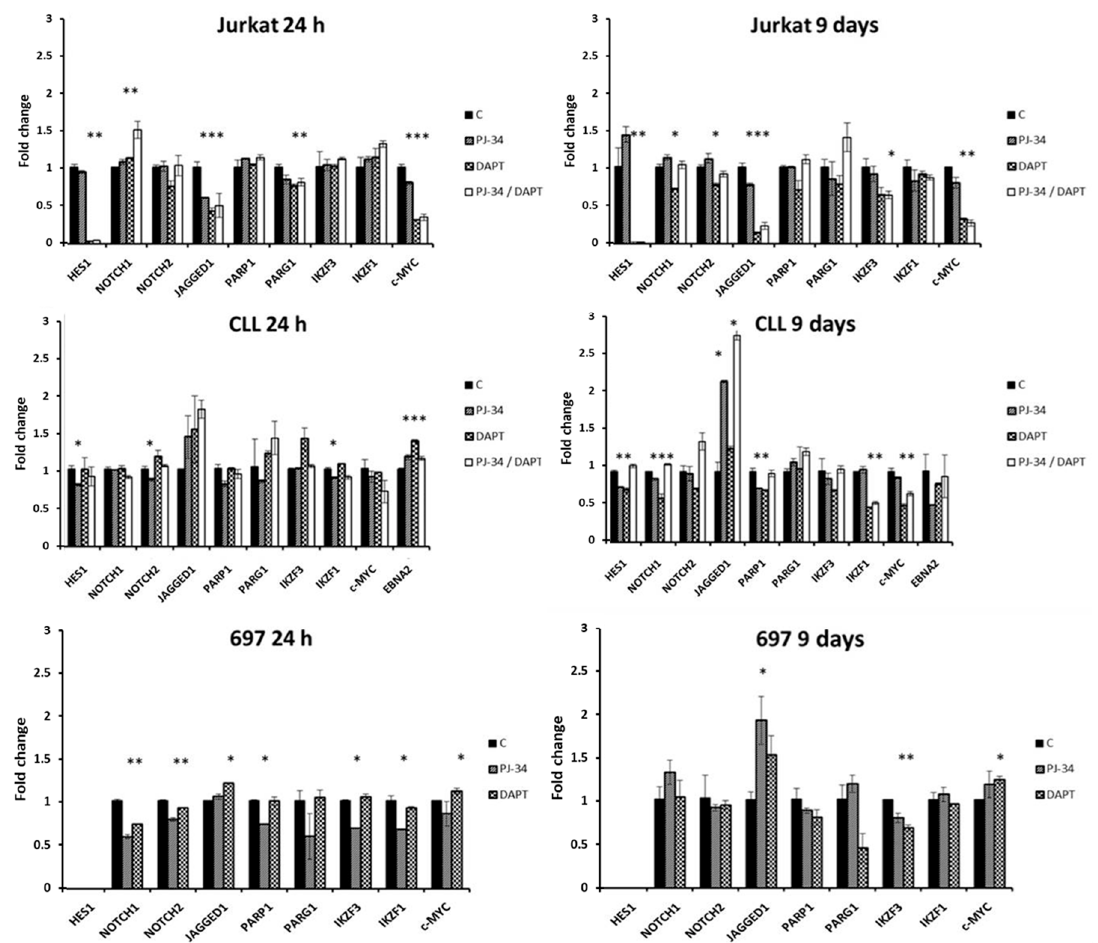
Figure 3. Influence of Notch and PARP pathways’ inhibition in Jurkat, CLL, and 697 cell lines. Cells were treated with PARP inhibitor PJ-34 and/or Notch inhibitor DAPT every other day through nine days, when RNA was isolated and, after reverse transcription, qRT-PCR was performed. Representative results are shown. Relative expression is presented as a fold change in comparison with untreated control sample values. As endogenous control gene HPRT expression was used. C: control cells; PJ-34: cells treated with PJ-34 (10 µM for CLL and Jurkat cells and 40 µM for 697); DAPT: 20 µM DAPT; PJ-34/DAPT: cells treated with combination of 10 µM PJ-34 and 20 µM DAPT; * p -value < 0.05.